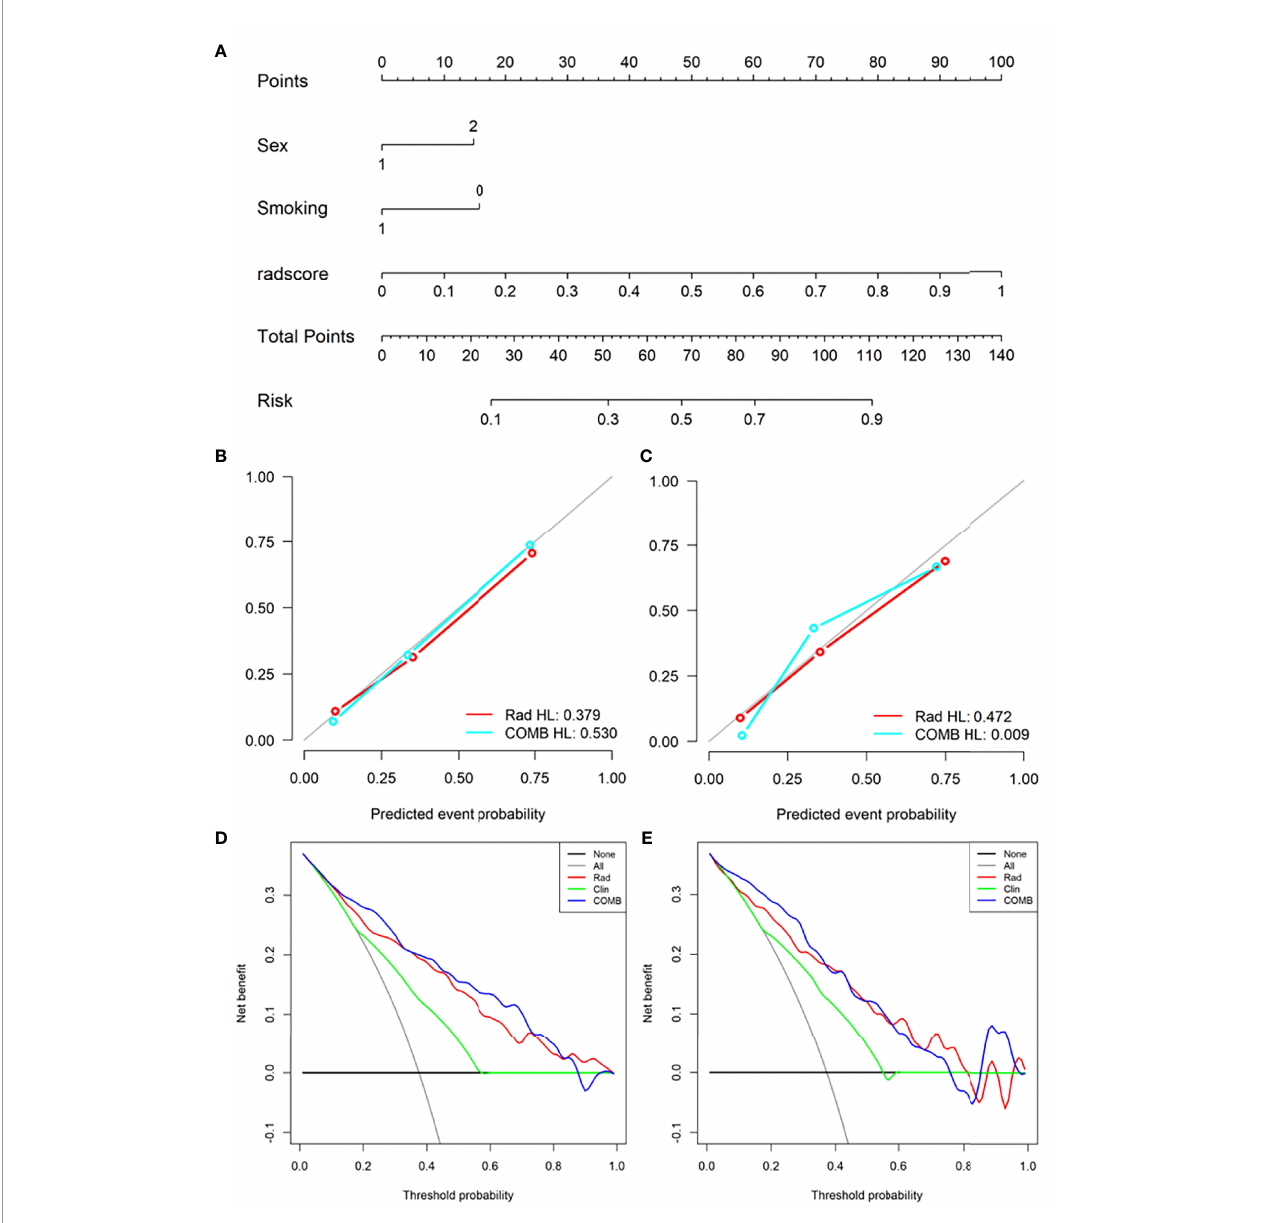
FIGURE 5 | Nomogram was used to identify L858R mutation and wild-type. (A) Construct a nomogram in the training set based on the combined model. (B, C) Calibration curve of the combined model in the training (B) and validation (C) sets. (D, E) Decision curve analysis for the combined model in the training (D) and validation (E)